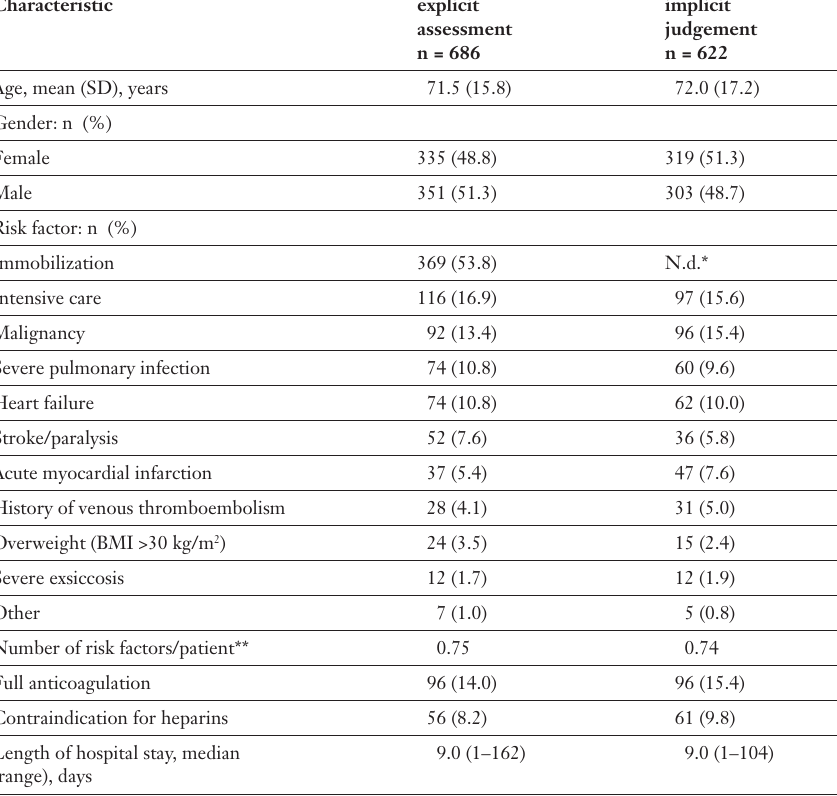
and risks for venous thromboembolism (VTE) in compared